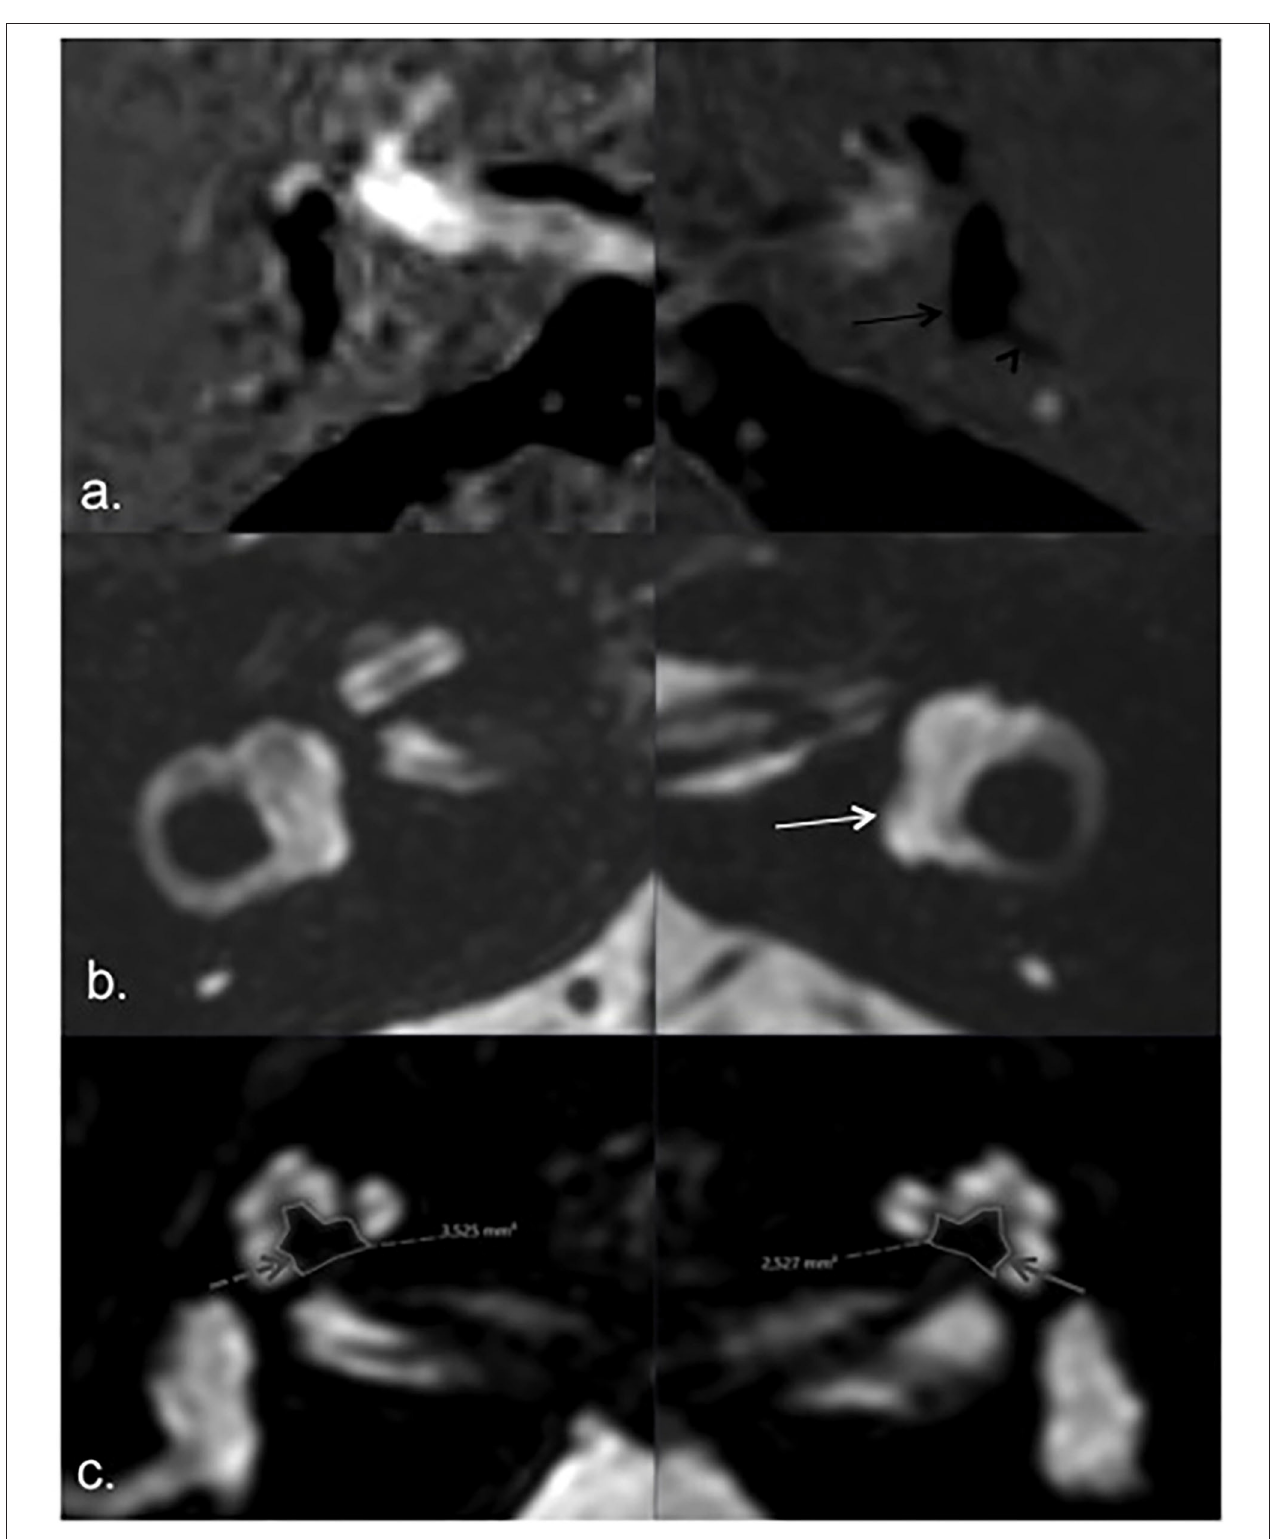
FIGURE 4 | MRI of patient 1. HYDROPS (a) and T2 (b) axial images showing endolymphatic (black arrow) and total membranous labyrinth (white arrow) respectively; bilateral vestibular endolymphatic hydrops, more pronounced on the left side (a. black arrow) with herniation of the utricle into the non-ampullary limb of the lateral semicircular canal (black arrowhead). Axial T2 image according to the greater axis of cochlear modiolus (c) , showing marked asymmetric modiolar areas, smaller on the left side (index ear) (solid gray arrow) compared to the left asymptomatic side (dashed gray arrow).